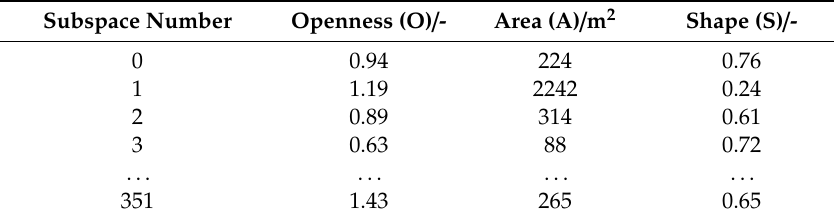
Table 2. Spatial characteristic indices of 352 subspaces ( ... stands for ellipsis).